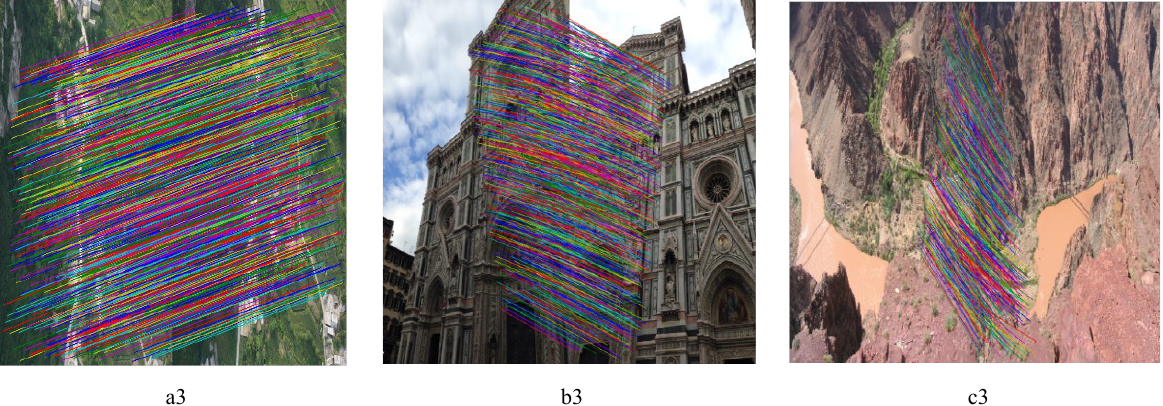
Figure 3. PCA-ORB algorithm matching results